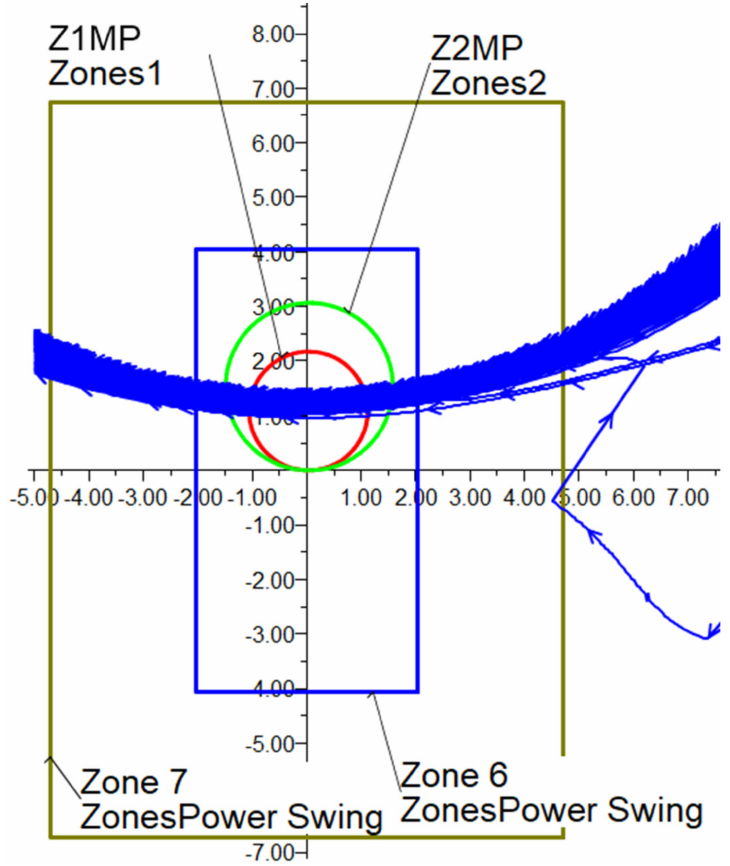
Figure 20. Test 2 : R-X plot without OOS relay on CCT-1